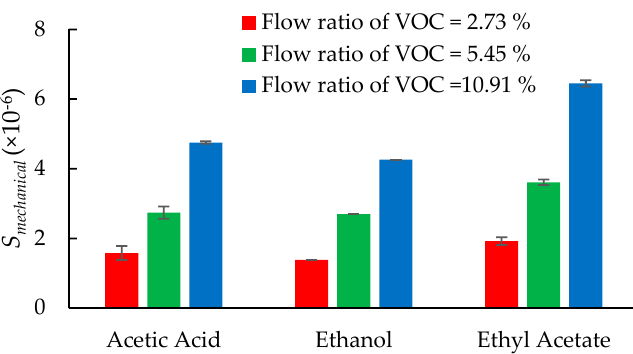
Figure 8. Perturbation in the series resonant frequency of the sensor upon exposure to various VOC molecules.